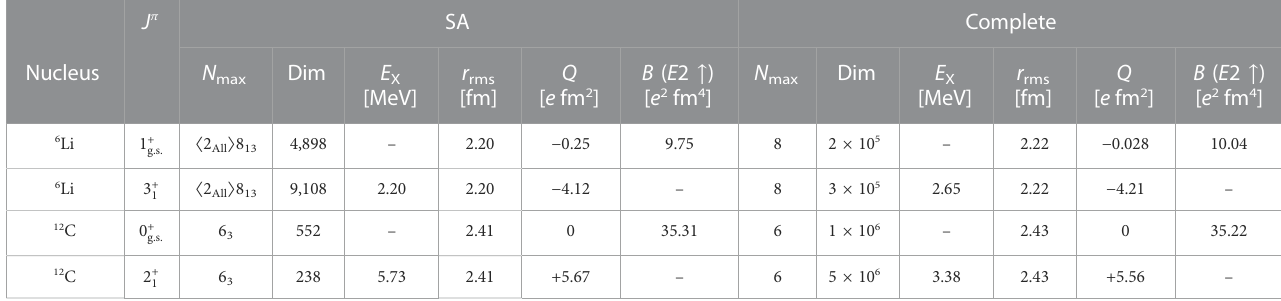
TABLE1Modelspacedimensions(labeledas “ Dim ” ),excitationenergy E X ,point-protonrmsradius r rms ,electricquadrupolemoment Q ,and B ( E 2 ↑ )transitionstrengths from the ground state (g.s.) to the fi rst excited state of 6 Li and 12 C, calculated with NNLO opt and - Ω = 15 MeV in SA and complete model spaces. 〈 2 All 〉 8 13 denotes an N max = 2 model space with all symplectic irreps (complete), 13 Sp (3,